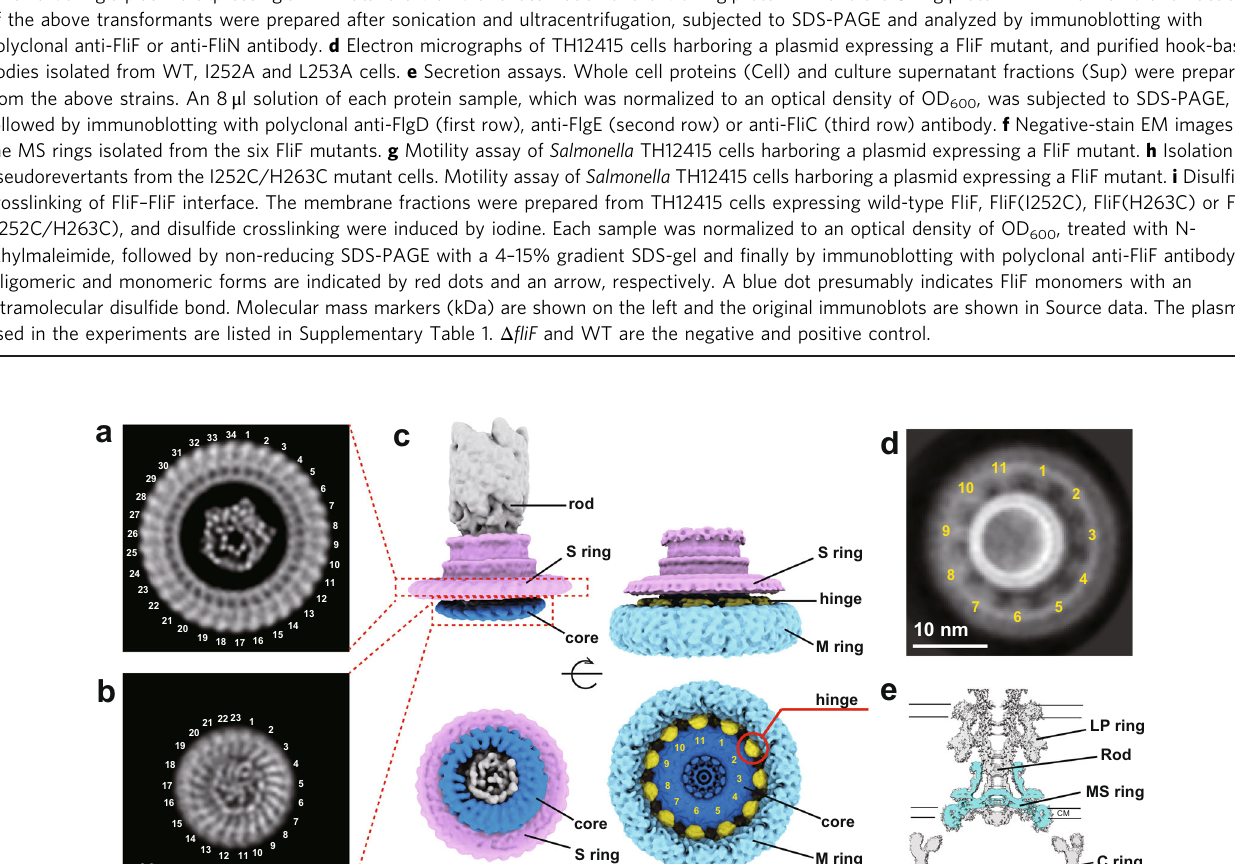
Fig. 3 Mutational analysis of conserved Ile-252, Leu-253 and Val-266. a Molecular interface between FliF subunits. Ile-252, Leu-253, and Val-266 are located at an interface between FliF subunits. His-263 and Ala-388 are in close proximity to Ile-252. b Motility assay on soft agar of Salmonella TH12415